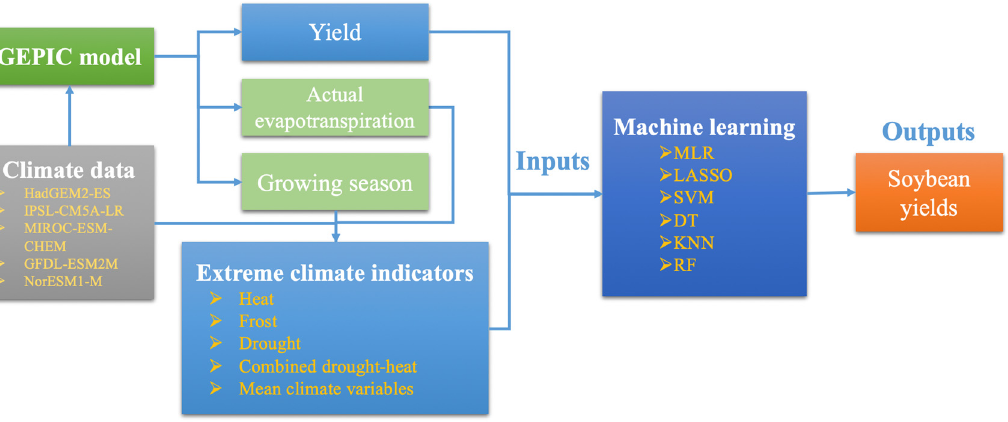
Figure 1. The process of the hybrid model.